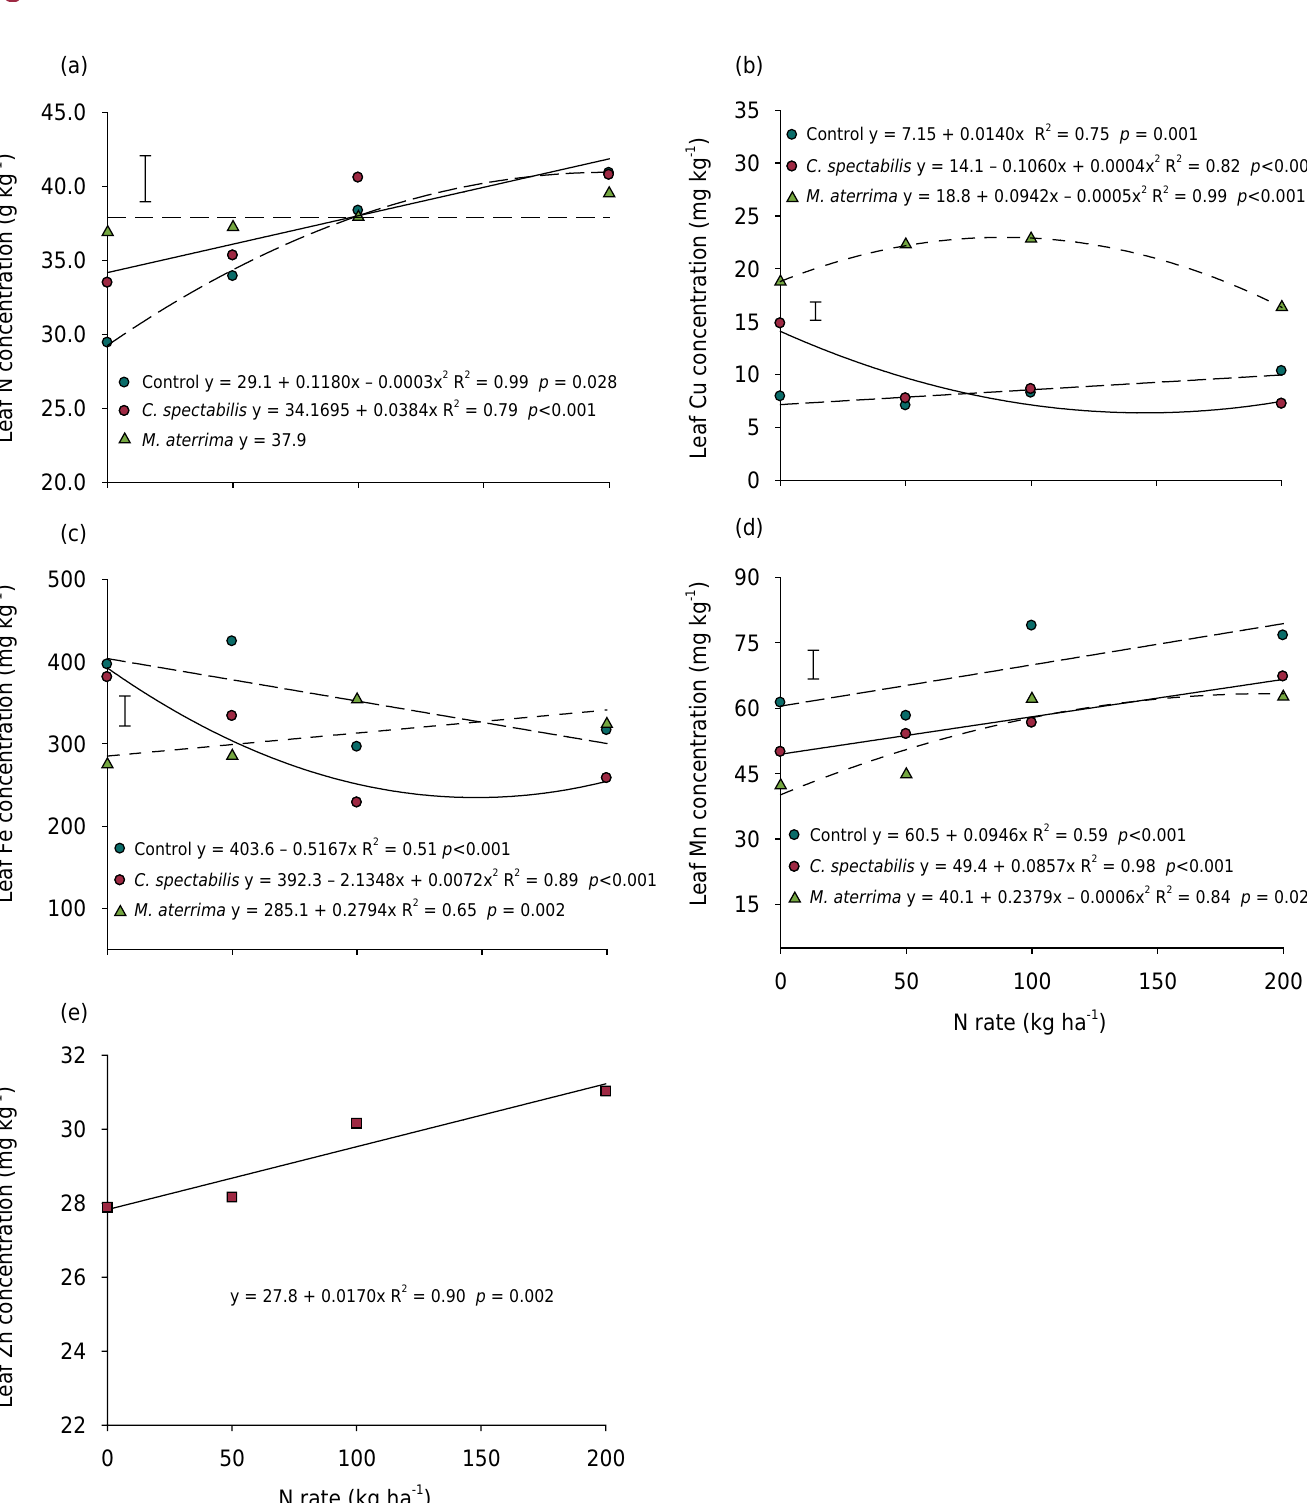
Figure 2. Nitrogen (a), Cu (b), Fe (c), Mn (d), and Zn (e) concentration in the first fully expanded leaves of sweet potato in response to green manure cultivation and N application rate. Square: mean of the three green manure treatments (Control, C. spectabilis , and M. aterrima ). Vertical bars represent the least significant difference at p≤ 0.05 according to LSD test. Data are the means of the two agricultural